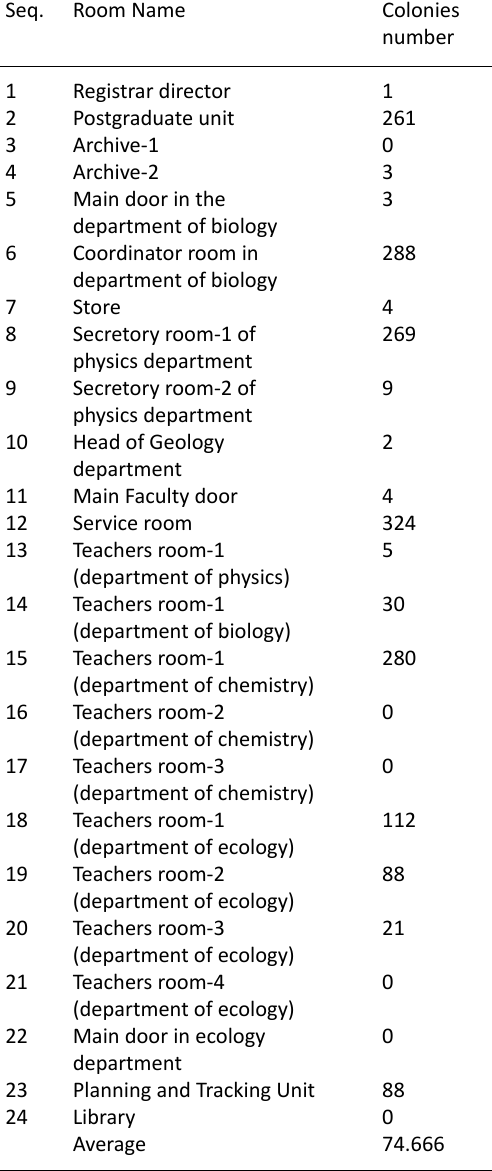
Table 3. Bacterial contamination of office doors handles